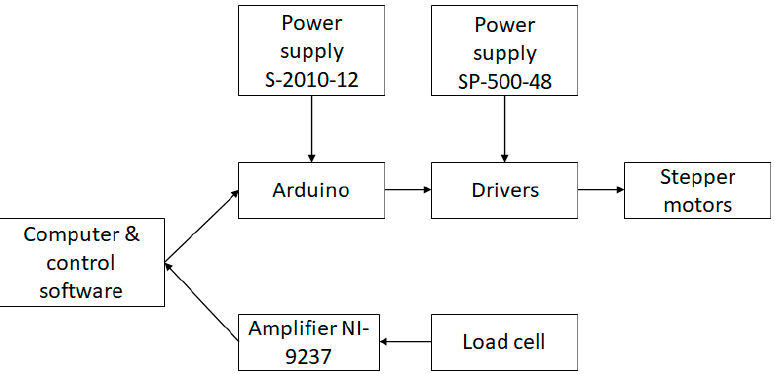
Figure 13. Schematics of the main electrical connections.